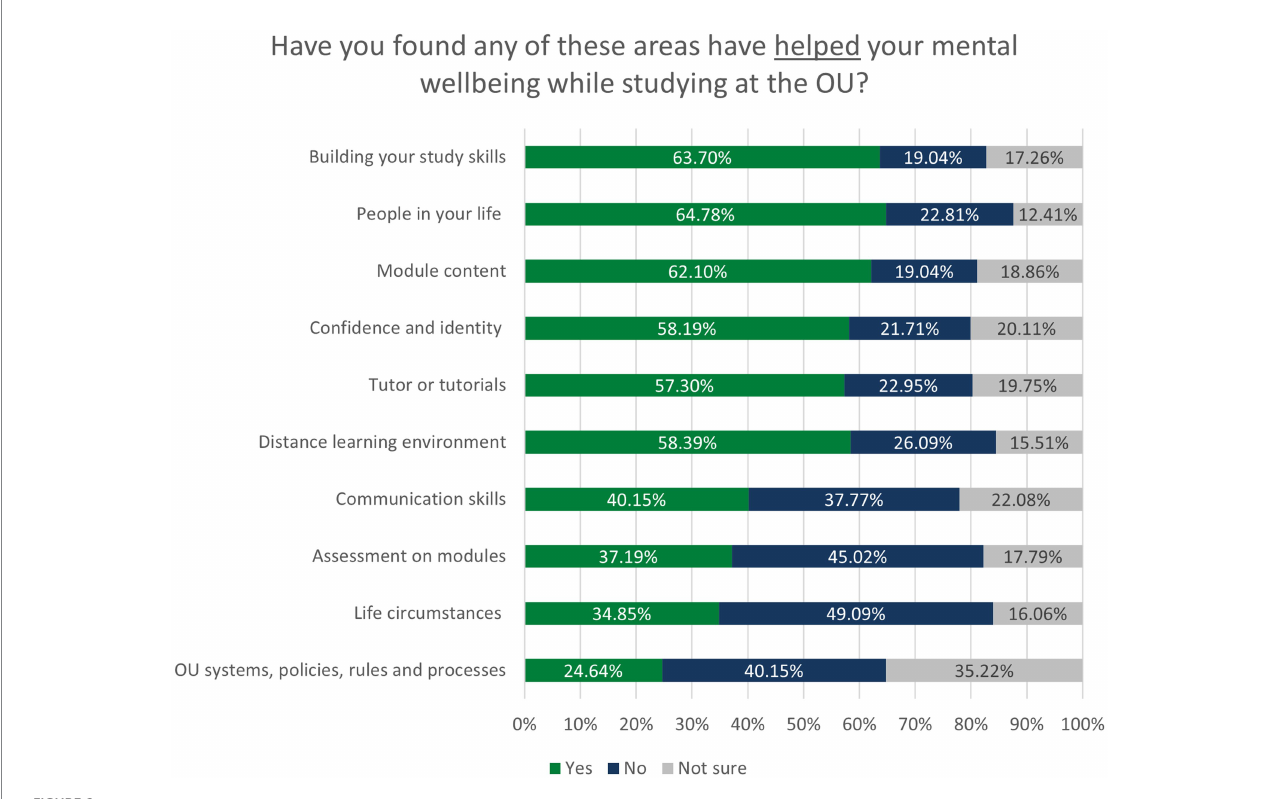
FIGURE 6 Factors that enhanced student wellbeing in